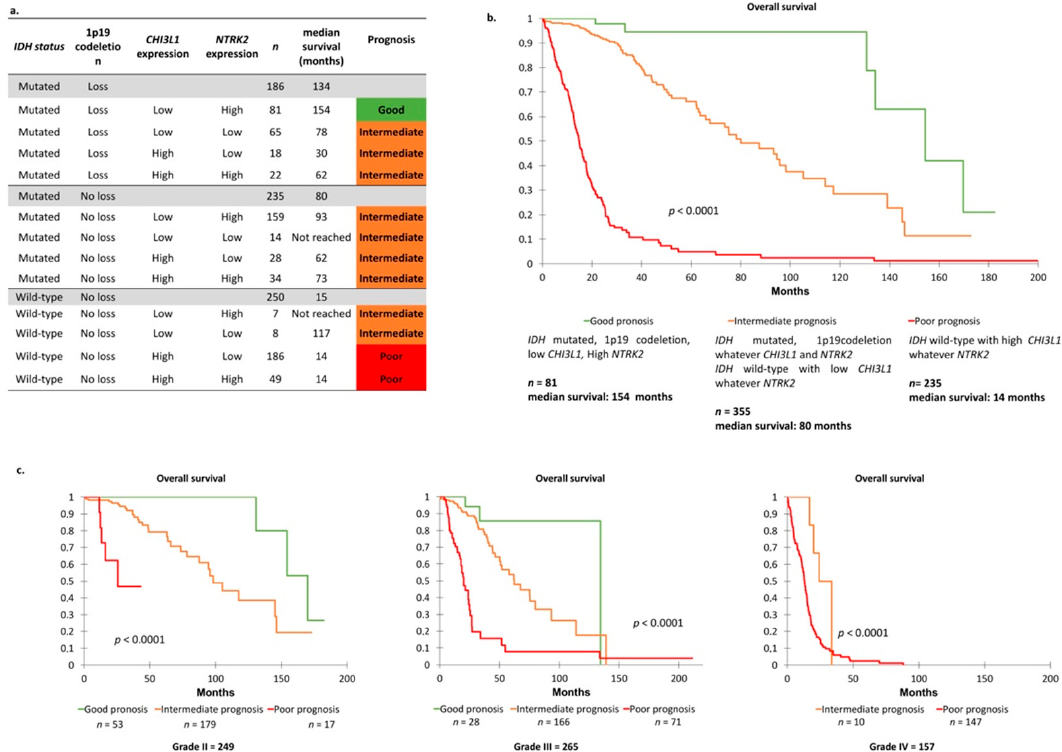
Figure 5. ( a ) Overall survival in glioma molecular groups according IDH status, 1p19 co-deletion and CHI3L1 and NTRK2 expression. ( b ) Overall survival in three glioma molecular groups by Kaplan–